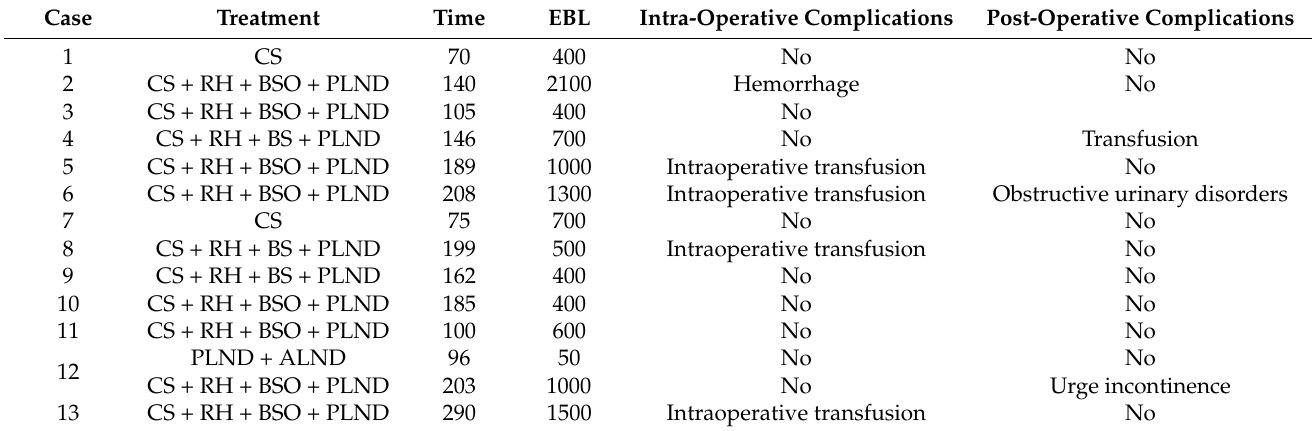
Table 2. Characteristics of surgery performed during pregnancy and intra- and post-operative